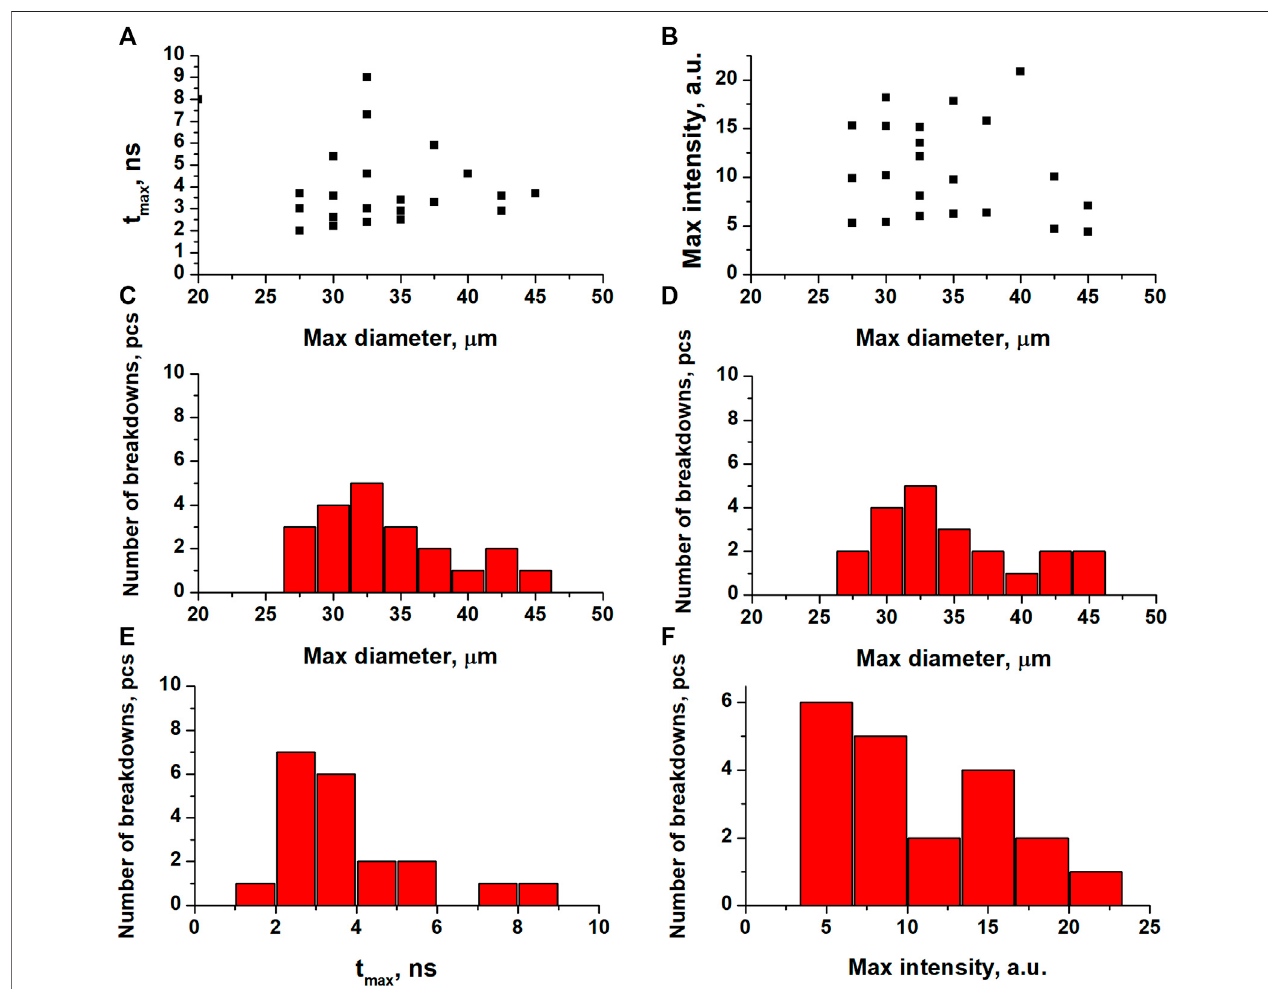
FIGURE 3 | (A) - Distribution of plasma fl ashes depending on the maximum size and the t max parameter; (B) - Distribution of plasma fl ashes depending on the maximum diameter and intensity; (C) — Distribution of plasma fl ashes over maximum sizes according to the data in Figure 3A . (D) — Distribution of plasma fl ashes by maximum size according to Figure 3B ; (E) — Distribution of plasma fl ashes according to the maximum intensity; (F) — Distribution of plasma fl ashes over time t max .